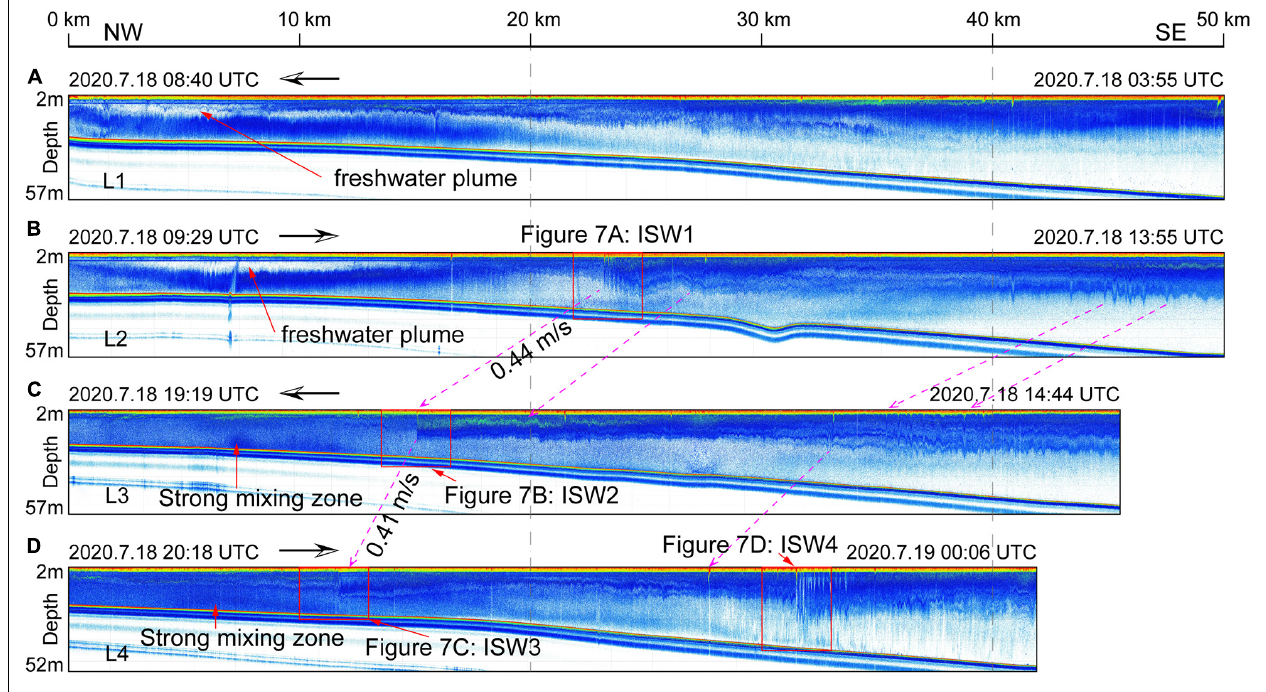
FIGURE 2 | Acoustic backscatter images of ISWs show the fine structure of the water column along the survey lines of L1 (A) , L2 (B) , L3 (C) , and L4 (D) in Figure 1 . The survey times and directions are marked by notes and black lines with arrows. Magenta dashed lines with arrows indicate that the same wave crests acquired more than once in different backscatter images, and the mean phase velocities between ISW1, ISW2, and ISW3 are marked. Note that a soliton train (ISW1, ISW2, and ISW3), with apparent vertical and horizontal scales of ∼ 7 and 100 m, respectively, was captured up to three times within 20 h.